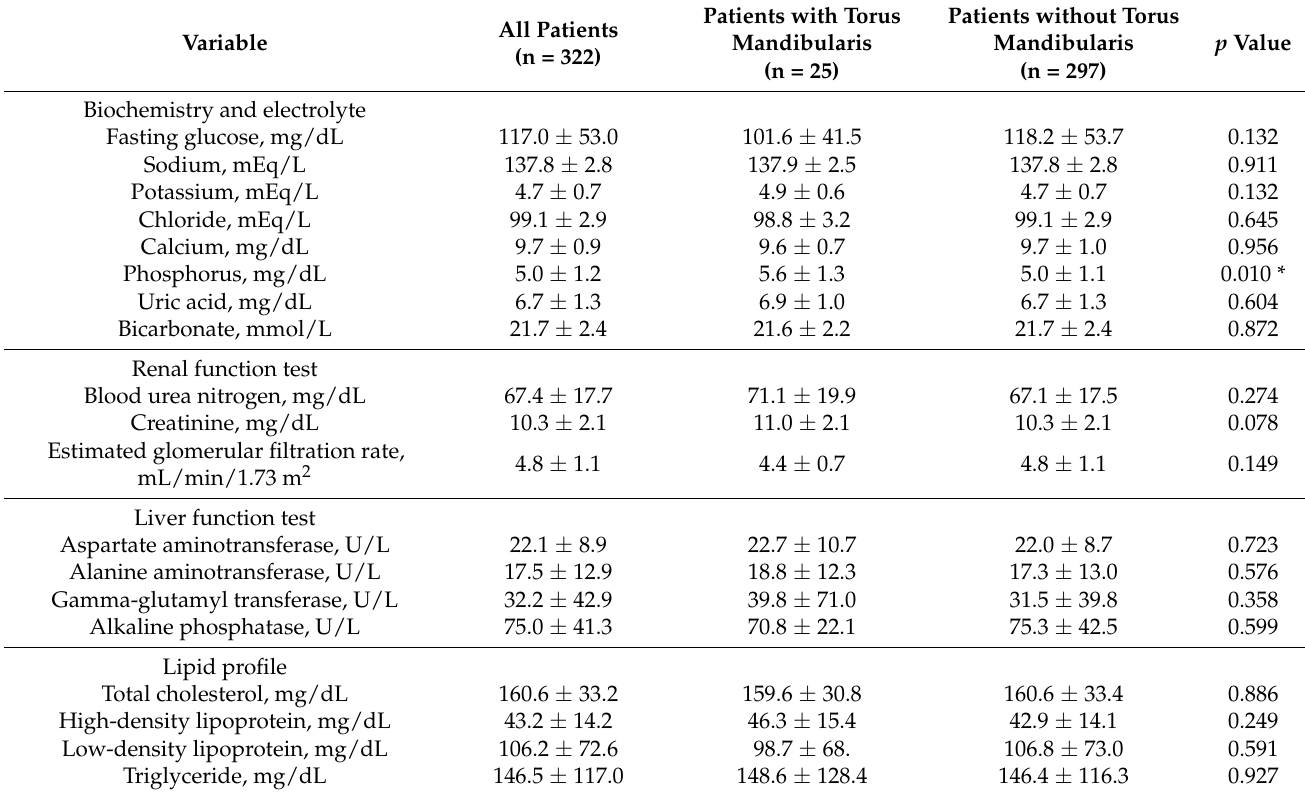
Table 2. Laboratory data of hemodialysis patients with and without torus mandibularis (n = 322).